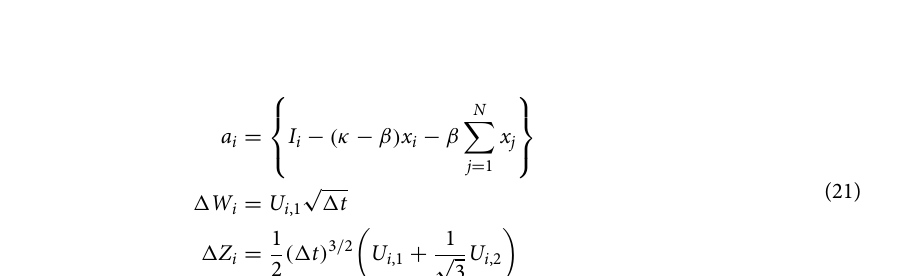
Table 3. Calibrated results for the case of three